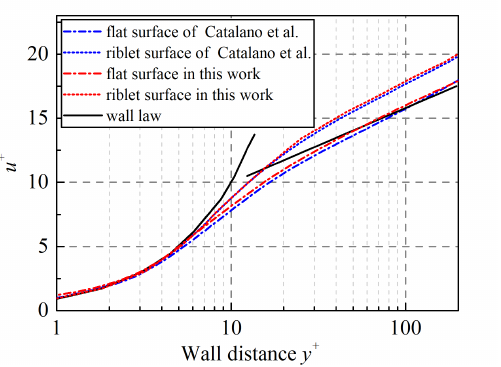
Figure 10. Comparison work of velocity profiles in the present work with the modified RANS model in